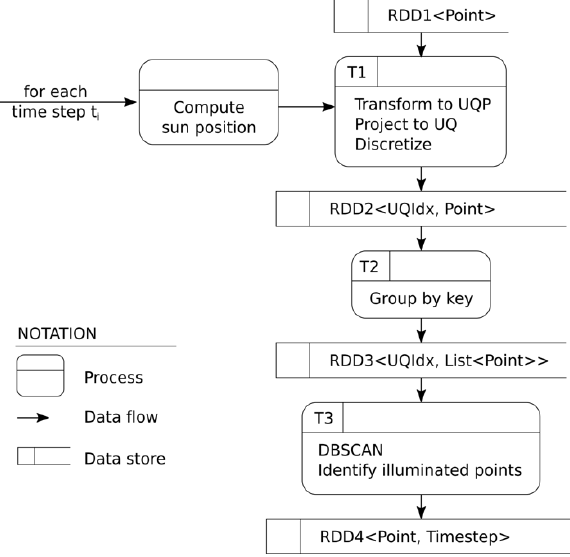
Figure 2. Acyclic data flow diagram representing the Spark